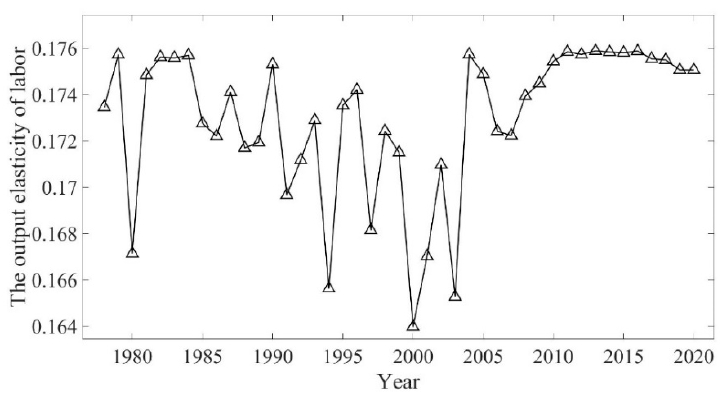
Figure 3. The output elasticity of labor from 1978 to